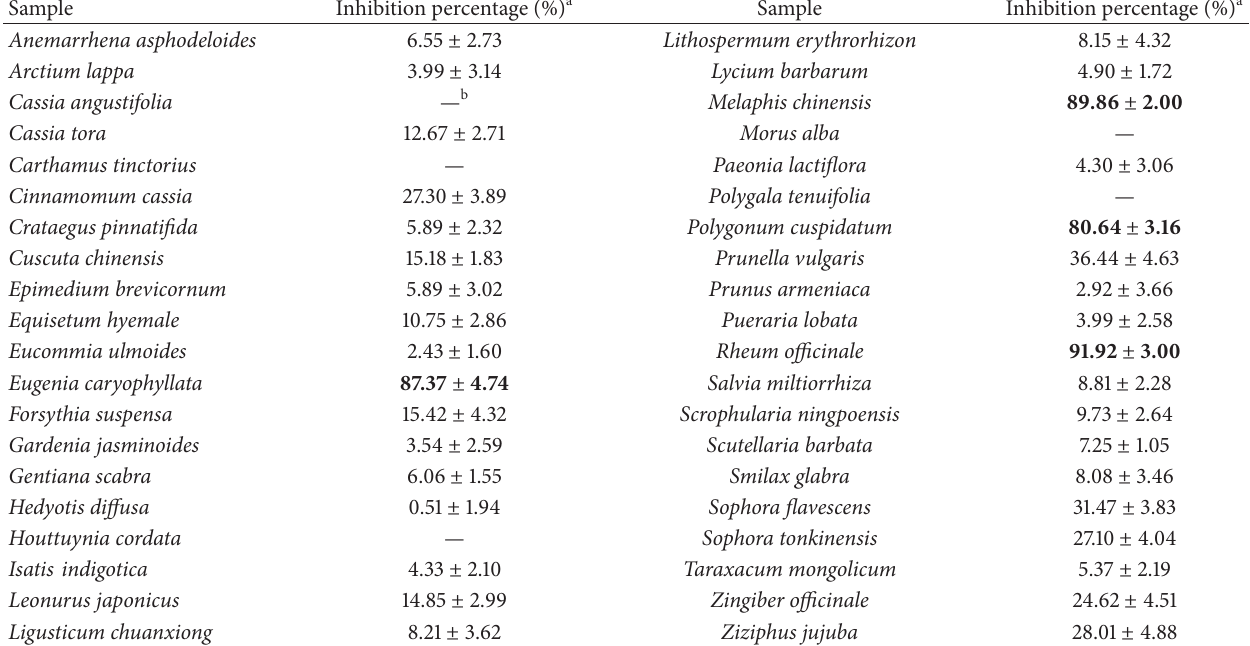
Table 1: The preliminary antifungal screening of the different herbal extracts on conidial germination of Colletotrichum higginsianum PA-01.